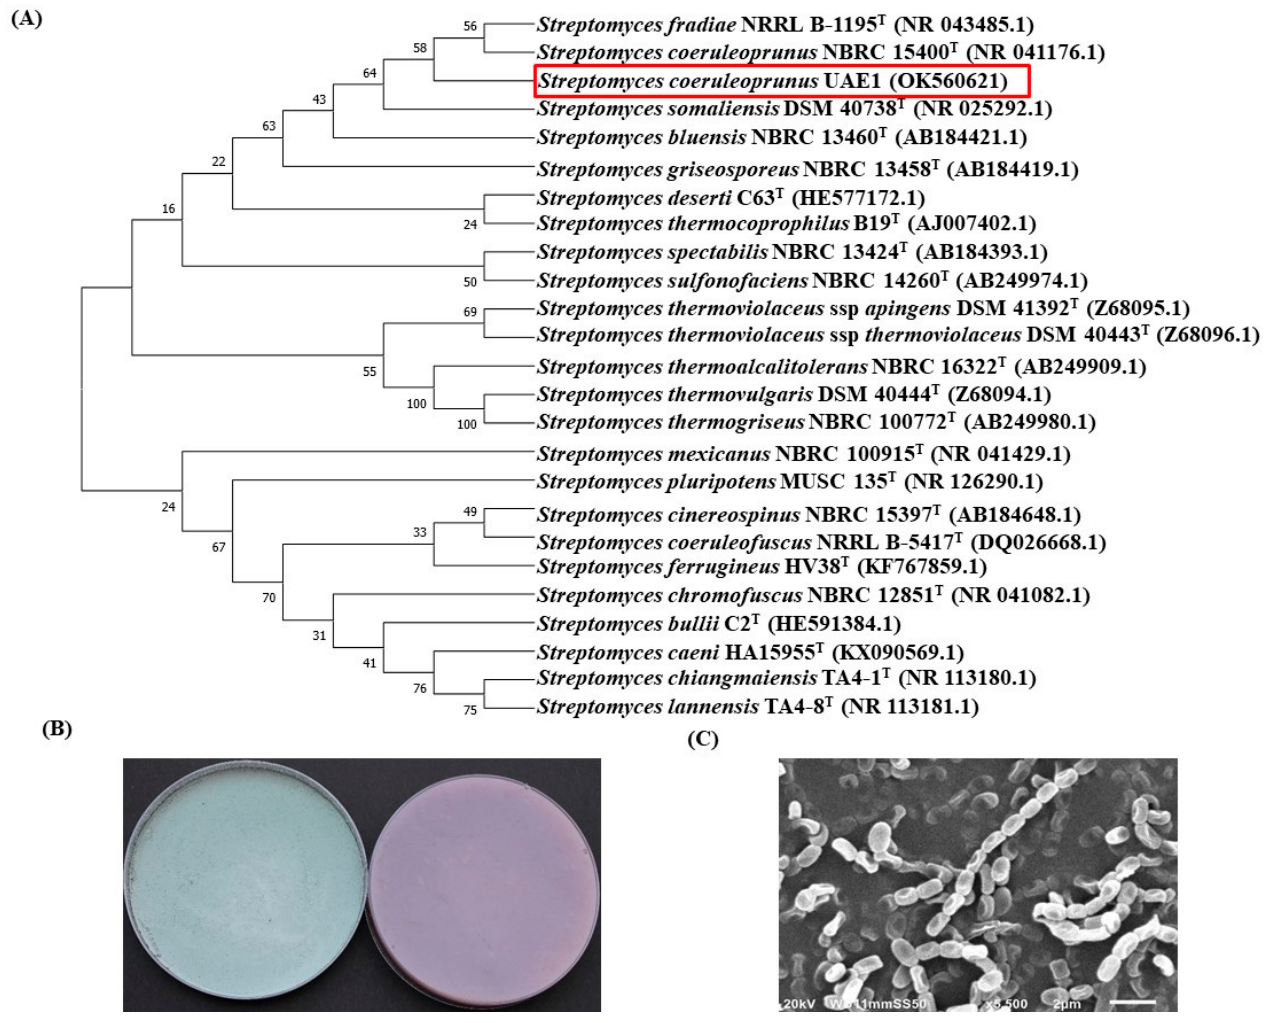
Figure 5. Molecular, cultural, and morphological characteristics of Streptomyces coeruleoprunus UAE1. Identification of S. coeruleoprunus UAE1 (BCA2) according to ( A ) the dendrogram that showing the phylogenetic relationships between S. coeruleoprunus UAE1 (NCBI accession #: OK560621) and other members of Streptomyces spp. based on the 16S rRNA sequences prepared by the neighbor-joining method; ( B ) light blue aerial mycelium (left) and pink to gray-violet substrate mycelium (right) growing on (ISP medium 3) supplemented with yeast extract, and ( C ) scanning electron micrograph (5500X) of the straight spore chains (section rectiflexibiles) and smooth-surfaced spores of S. coeruleoprunus UAE1. In ( A ), numbers at nodes indicate percentage levels of bootstrap support based on a neighbor-joining analysis of 500 resampled datasets. GenBank accession numbers are given in parentheses. BCA, biological control agent.